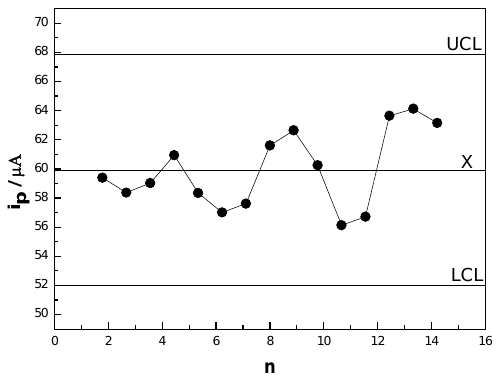
Figure 8. Quality control chart (X - Chart) of 4.5 × 10 -6 M meloxicam.